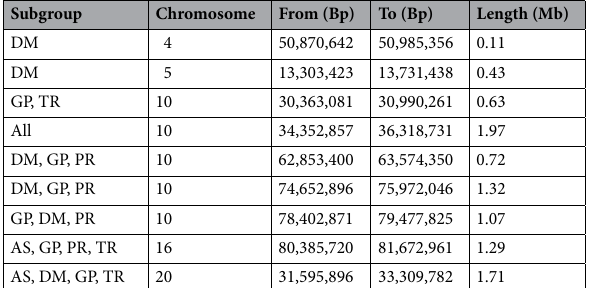
Table 3. Genomic location of the nine overlapping homozygous segments found within ROH in over 30% of animals within subgroup. AS = Asiago; DM = Drinkable Milk; GP = Grana Padano; PR = Parmigiano Reggiano; and TR = Trentingrana.